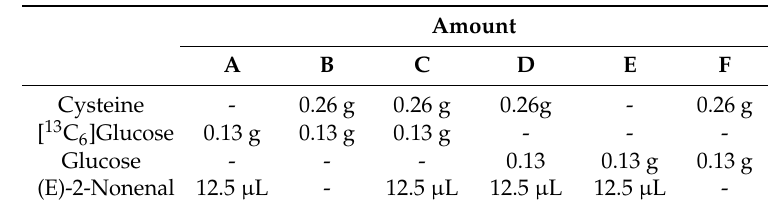
Table 1. Model reactions a